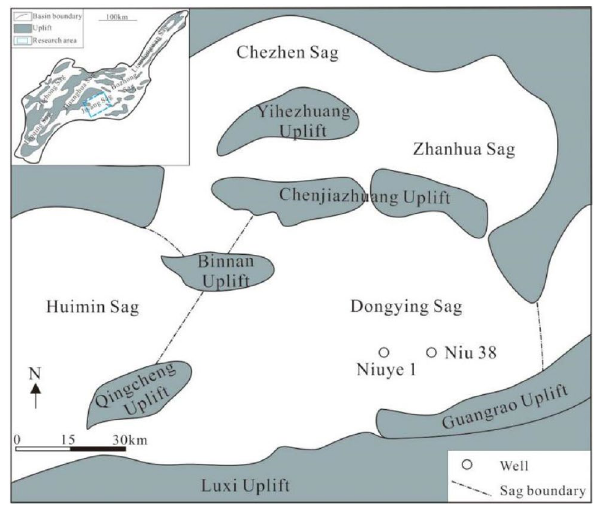
Fig. 1 Regional geological survey of the Jiyang